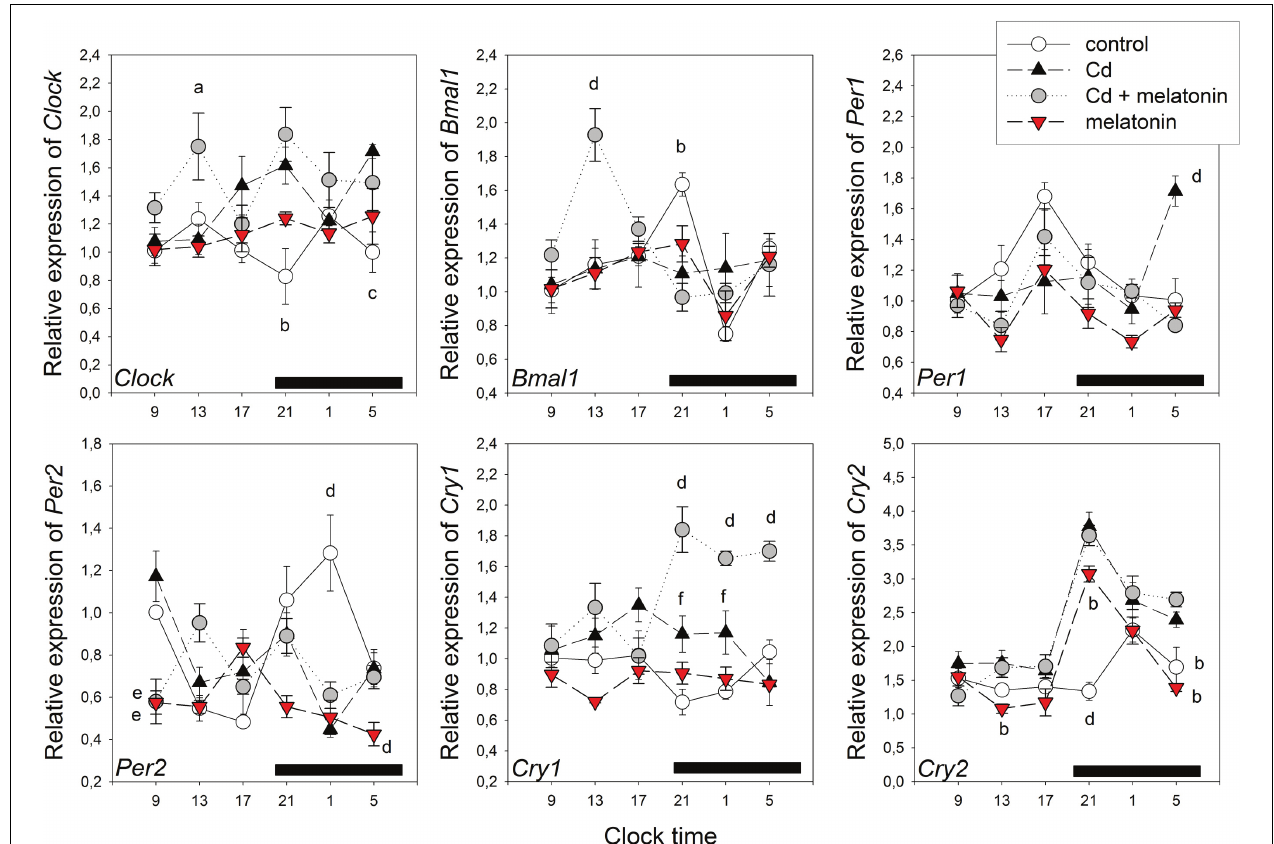
c p < 0.05 vs. Cd; d p < 0.01 vs. the remaining groups; e p < 0.01 vs. Cd and control groups; f p < 0.05 vs. control. One-way ANOVAs within each experimental group indicated significant time-related changes in clock gene expression as follows: Controls: Bmal1 , Per1 , Per2, and Cry2 ( F = 11.3, p < 0.0001, F = 2.54, p < 0.04, F = 7.94, p < 0.001, and F = 3.41, p < 0.03, respectively). Cd: Clock , Per1 , Per2, and Cry2 ( F = 4.71, p <